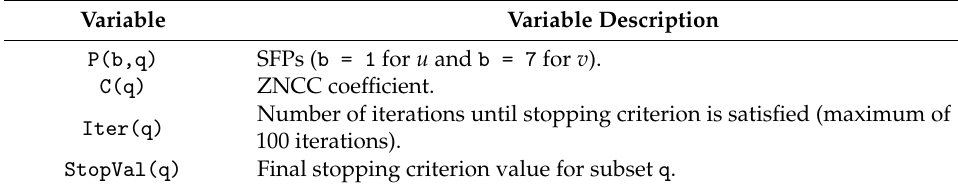
Table 2. Accessing the stereo matching data contained in ResultData.Stereo for subset q .